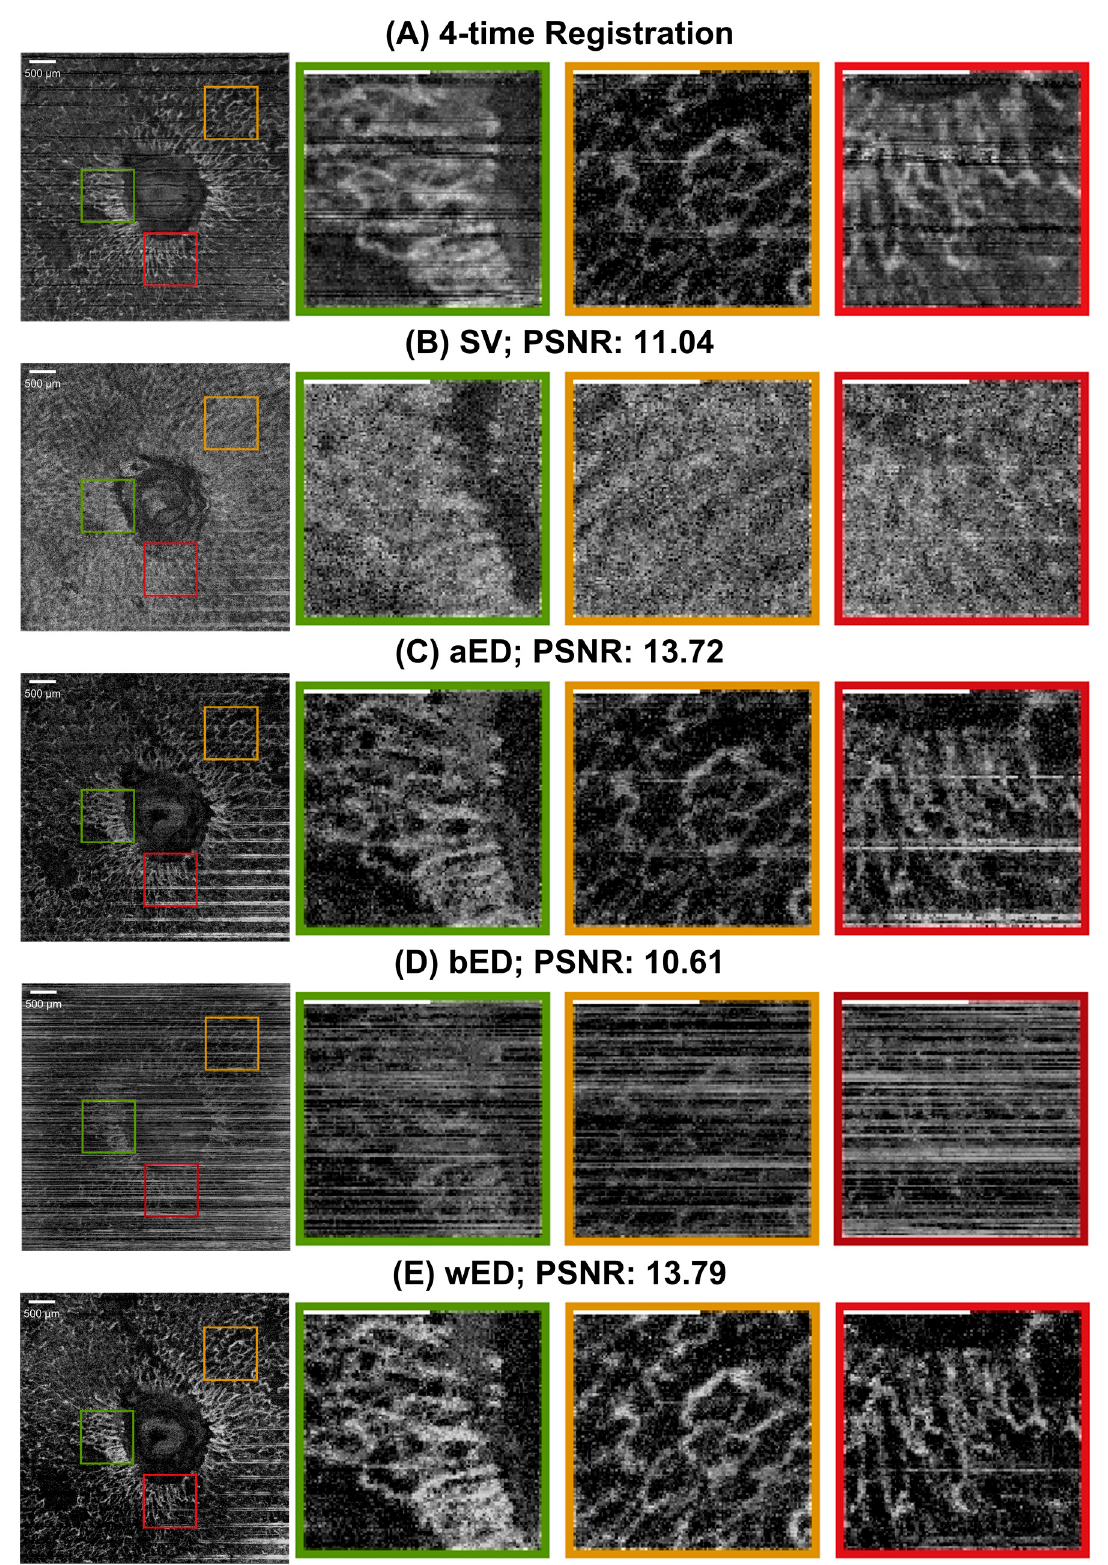
Figure A2. The comparisons of en face results from maximum intensity projection using different algorithms. ( A ) Registration from 4-time acquisitions; ( B ) SV; ( C ) aED; ( D ) bED; ( E ) wED. (All scale bars represent 500 μ m); SV: Speckle Variance; aED: A-scan eigen-decomposition; bED: B-scan eigen-decomposition; wED: windowed eigen-decomposition.